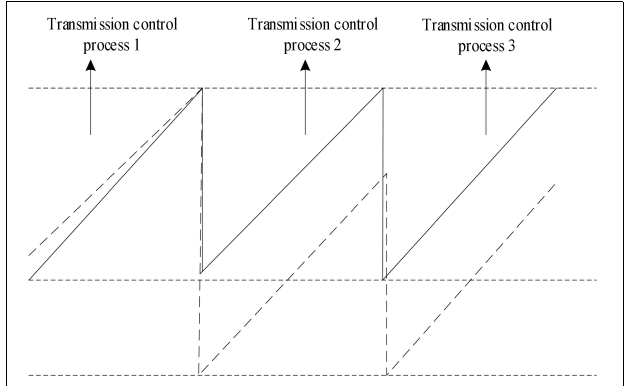
FIGURE 4 | Multistage transmission control process.